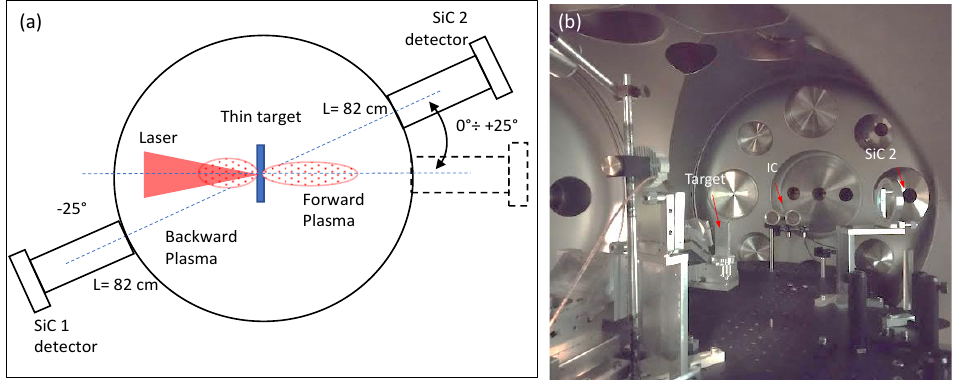
Figure 3. Scheme of the experimental setup ( a ) and a photo of the scattering chamber and of the thin target in the holder at IPPLM laboratory ( b ).